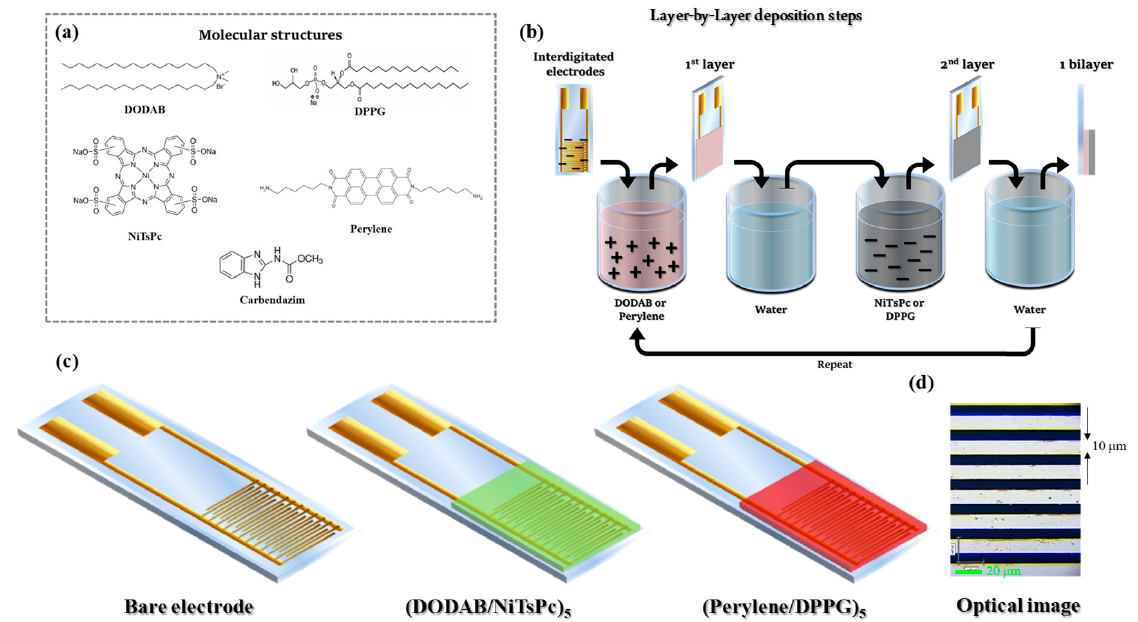
Figure 1. ( a ) Molecular structures of DODAB, DPPG, NiTsPc, Perylene and MBC. ( b ) Layer-by-layer deposition steps. ( c ) Sensing units composed by bare IDE and IDEs covered with LbL films of (DODAB/NiTsPc) 5 and (Perylene/DPPG) 5 . ( d ) Optical image of the IDE 10 showing the space of 10 µm between electrodes.